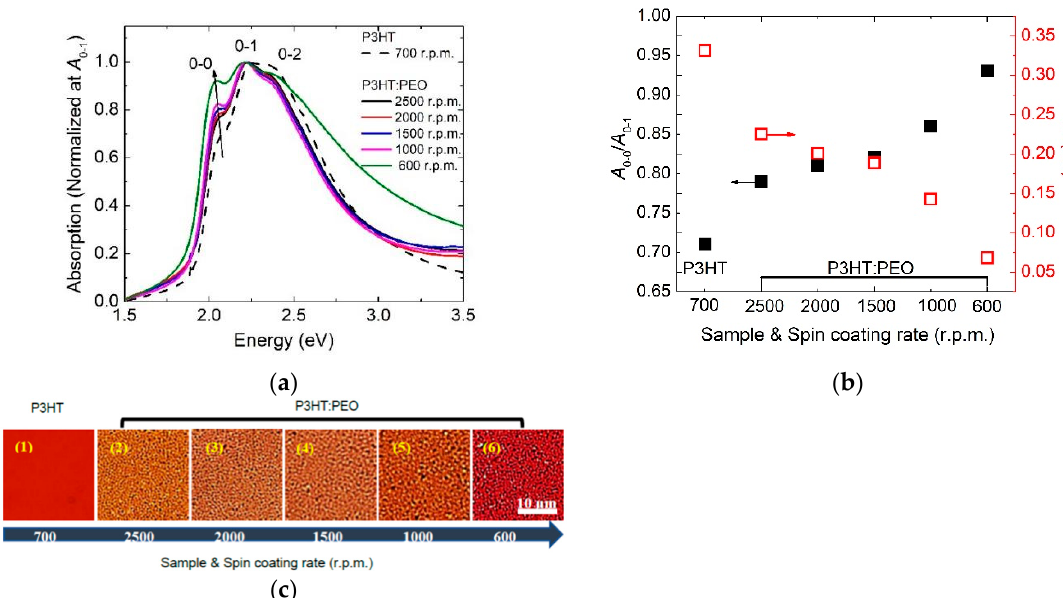
Figure 1. ( a ) UV-Vis absorption spectra of poly (3-hexylthiophene-2,5-diyl) (P3HT) and P3HT: poly (ethylene oxide) (PEO) film with different spin-coating rates. 0-0, 0-1, and 0-2 vibronic features reflect transitions from the ground state to the first excited state. All spectra are normalized at the 0-1 peak. ( b ) The vibronic transition ratio A 0-0 / A 0-1 and W are deduced from (a) and plotted as a function of the spin-coating rate. ( c ) Optical microscopic images of P3HT and P3HT: PEO film with different spin-coating rates.